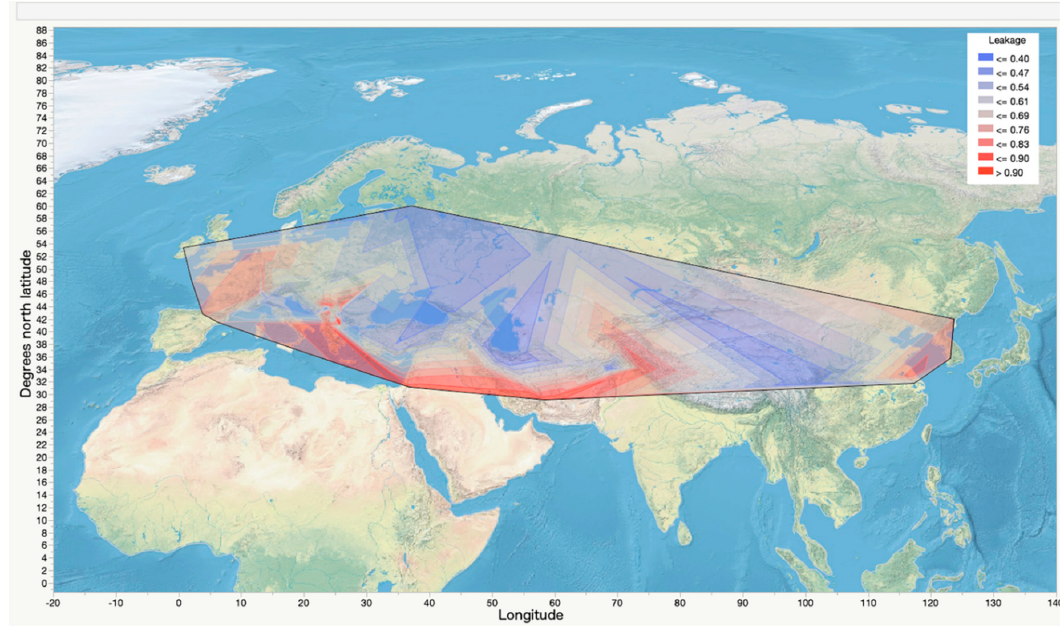
Figure 4. Contour plot of spline regression of freezing tolerance on latitude of origin of 192 wheat landraces collected from latitudes 27.5° N to 60° N and longitudes 9° W to 129.6° E, superimposed on a map of the world. Freezing tolerance was defined as electrolyte leakage following freezing to − 14, − 16, or − 18° C, expressed as a proportion of leakage following immersion in liquid nitrogen; lower numbers indicate greater freezing tolerance.